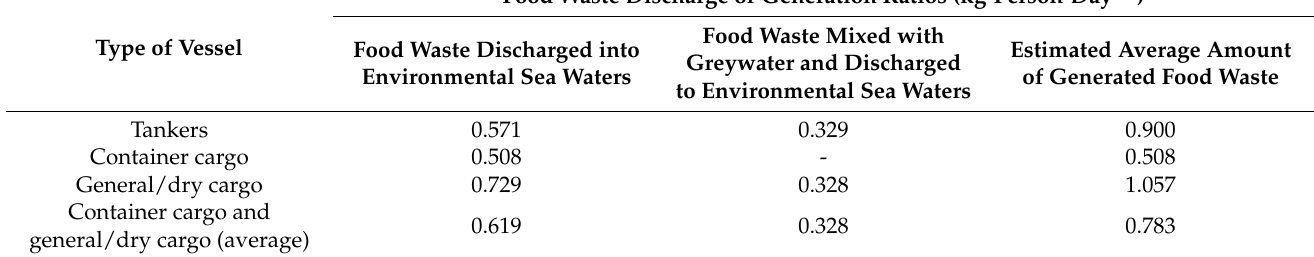
Table 3. The estimated average amounts of food waste generated and discharged, alone or together with greywater, by different ships.